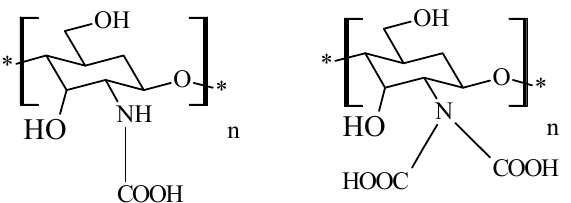
Figure 7. Structure of chitosan mono and dicarboxymethylates derivatives.